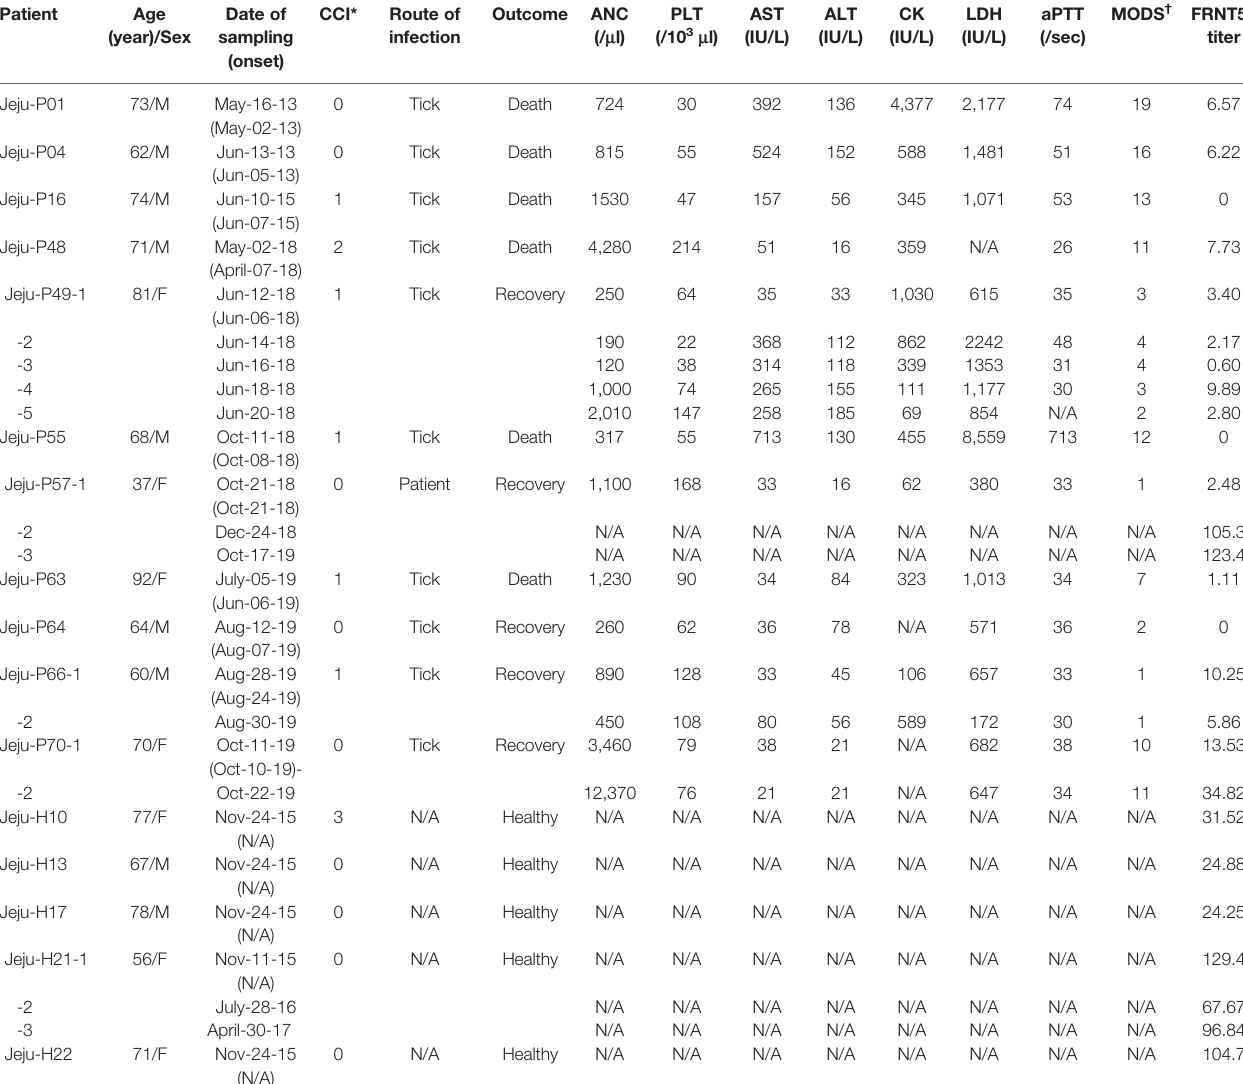
TABLE 1 | Baseline characteristics of the SFTS patients and healthy